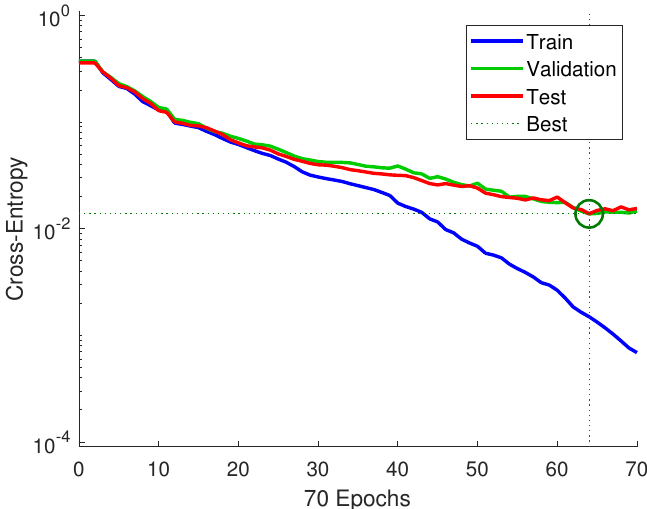
Figure 9. Training performance of the designed Feedforward neural